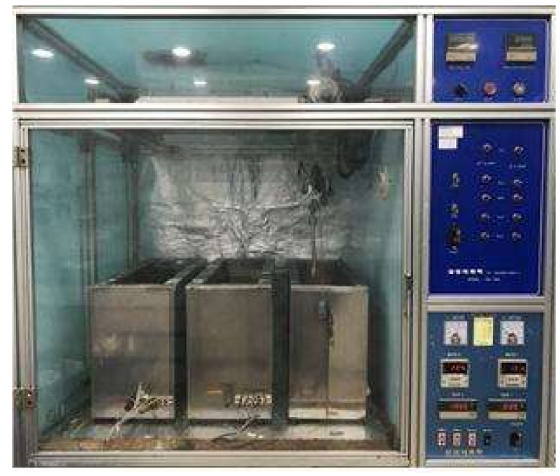
Figure A1. Small batch reactor setup for organosolv only pretreatment.